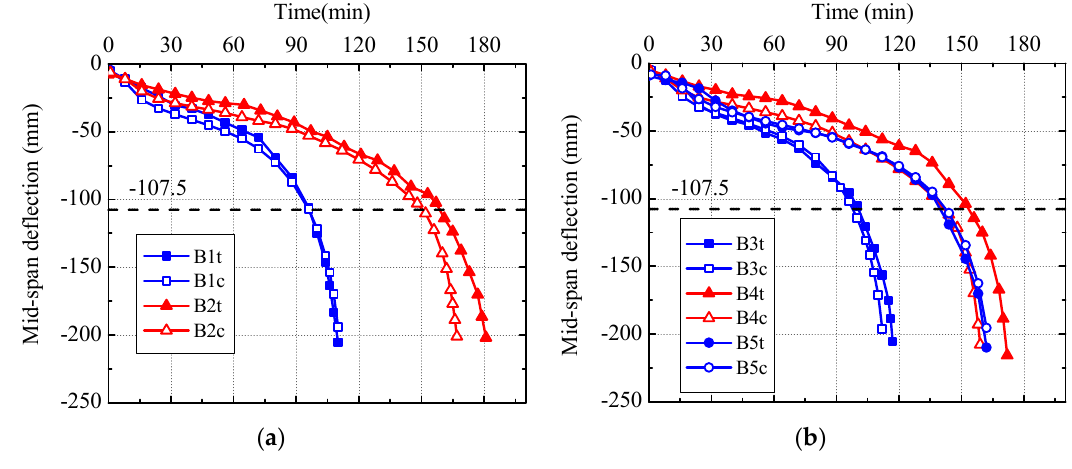
Figure 25. Calculated and measured mid-span deflection-time curves: ( a ) Specimens B1 and B2, and ( b ) Specimens B3, B4 and B5.